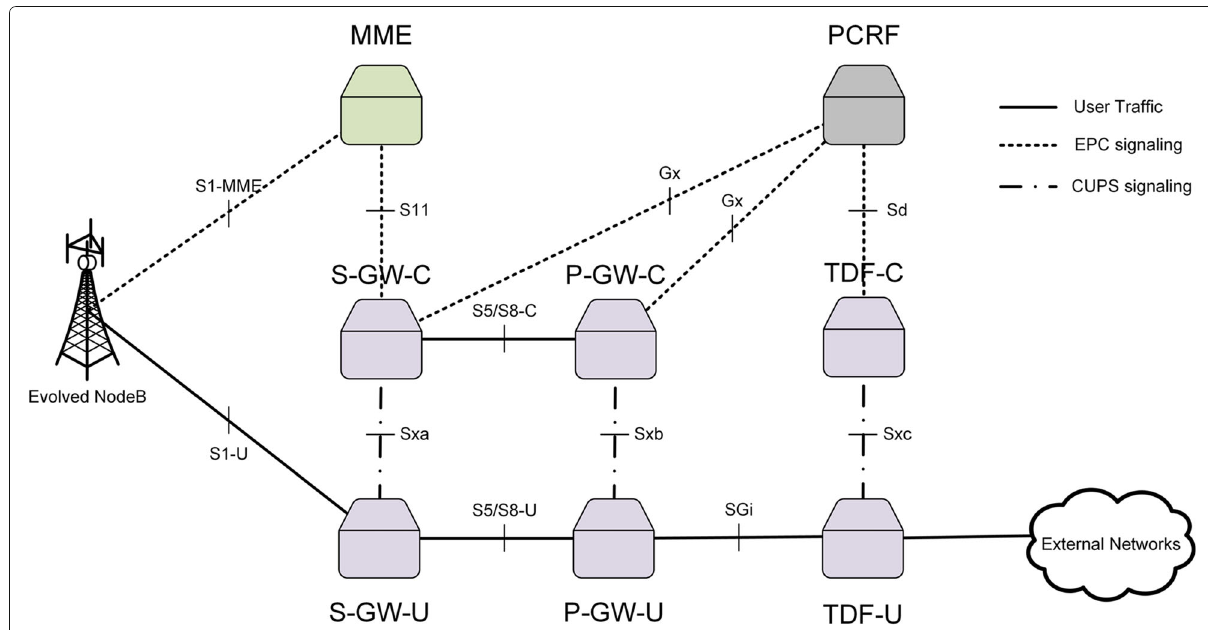
Fig. 7 5G CUPS network architecture. The S-GW and P-GW are split into control elements (S-GW-C and P-GW-C) and user elements (S-GW-U and PG-W-U)